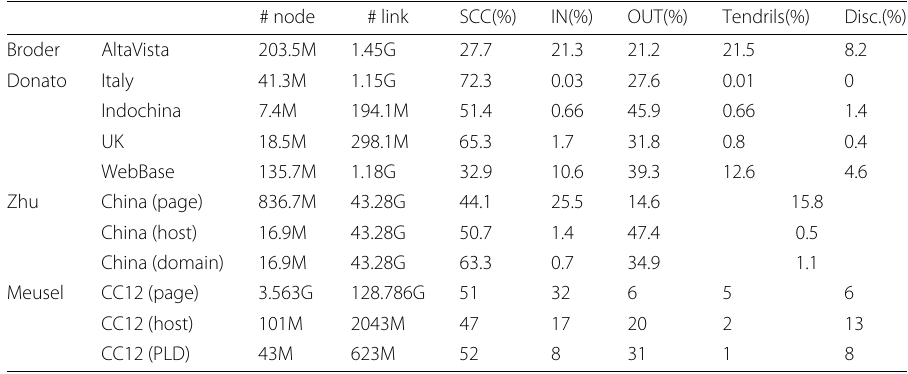
Table 1 Components of some web